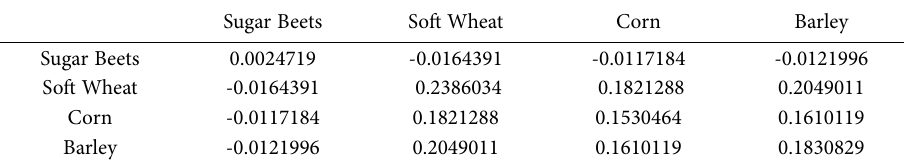
Table 4. Variance-covariance matrix of the market output